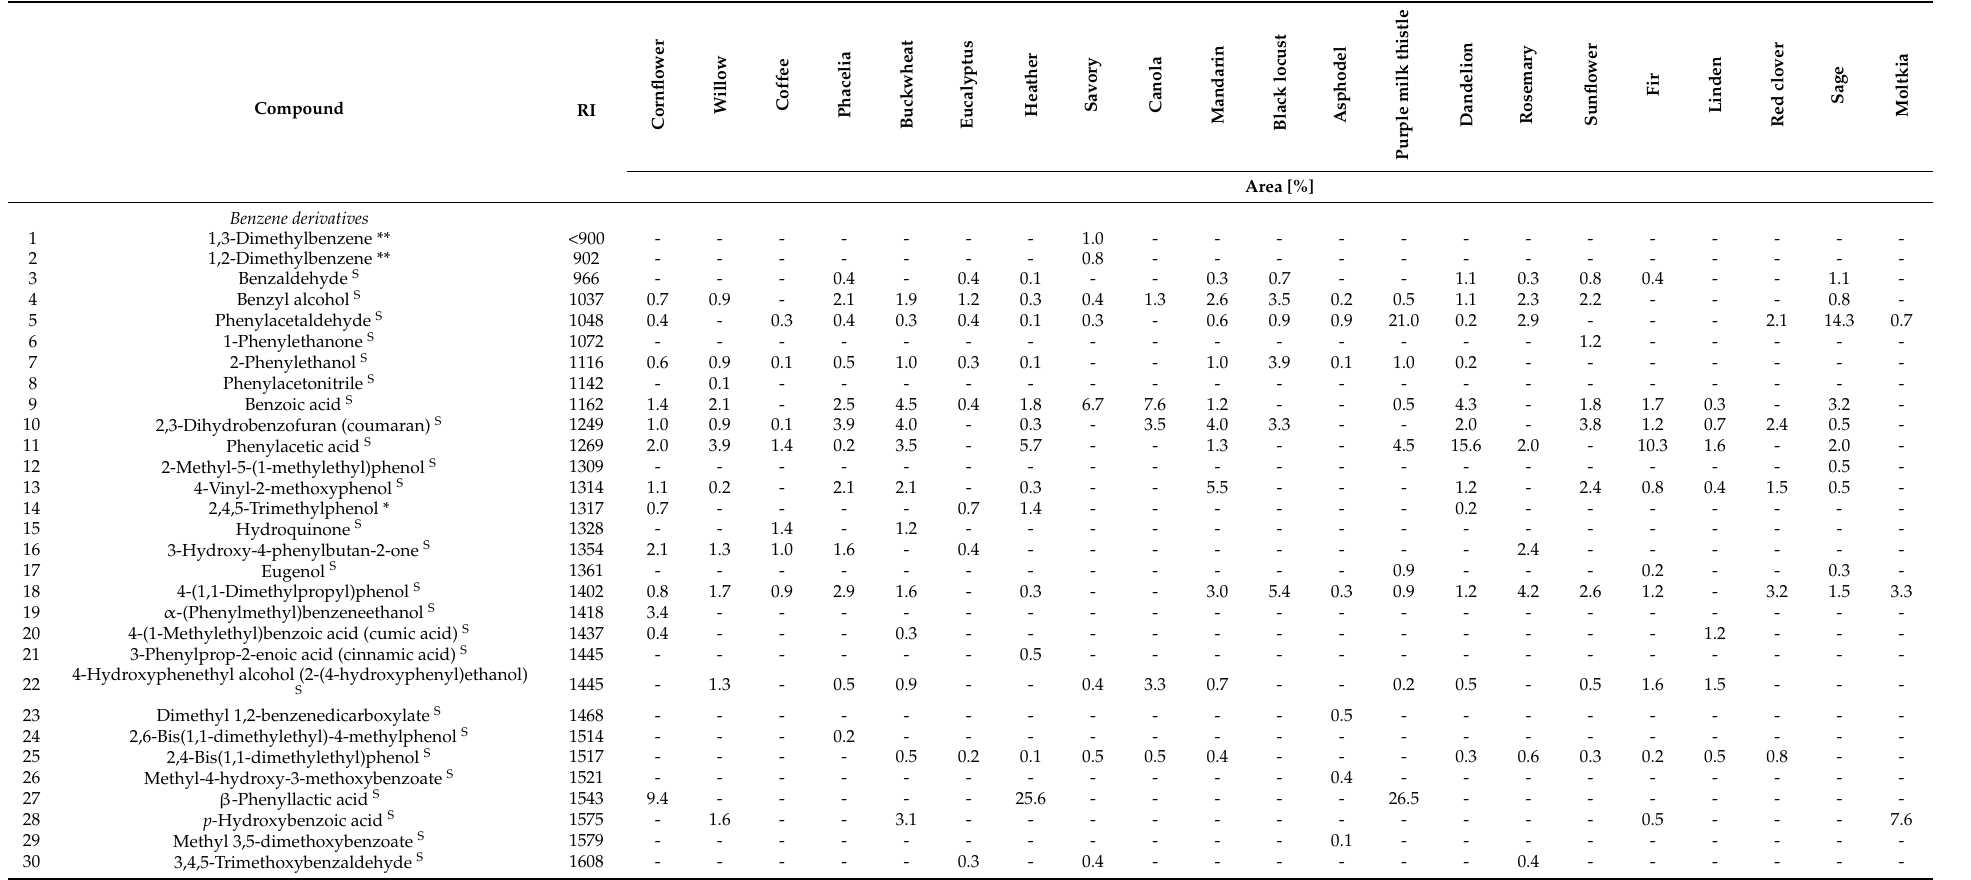
Table 1. The volatile profiles of the dehydration homogeneous liquid–liquid extraction (DHLLE) extracts obtained from the investigated honey varieties.